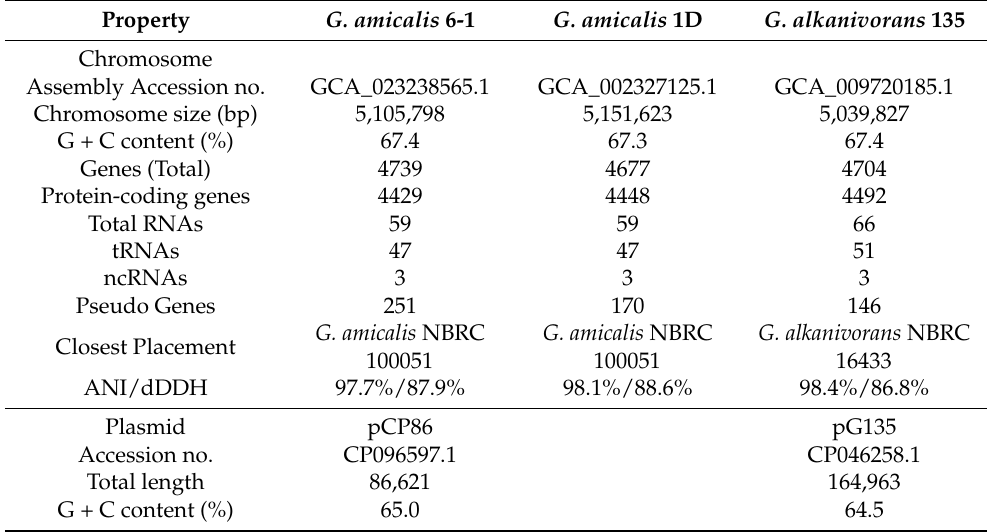
Table 1. Characteristics of the genome sequences (chromosome and plasmid) of hydrocarbon- oxidizing dibenzothiophene-degrading bacteria of the genus Gordonia used in this study. Property Chromosome Assembly Accession